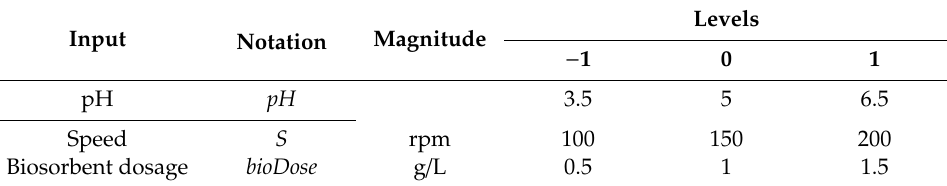
Table 2. Adsorption process variables and